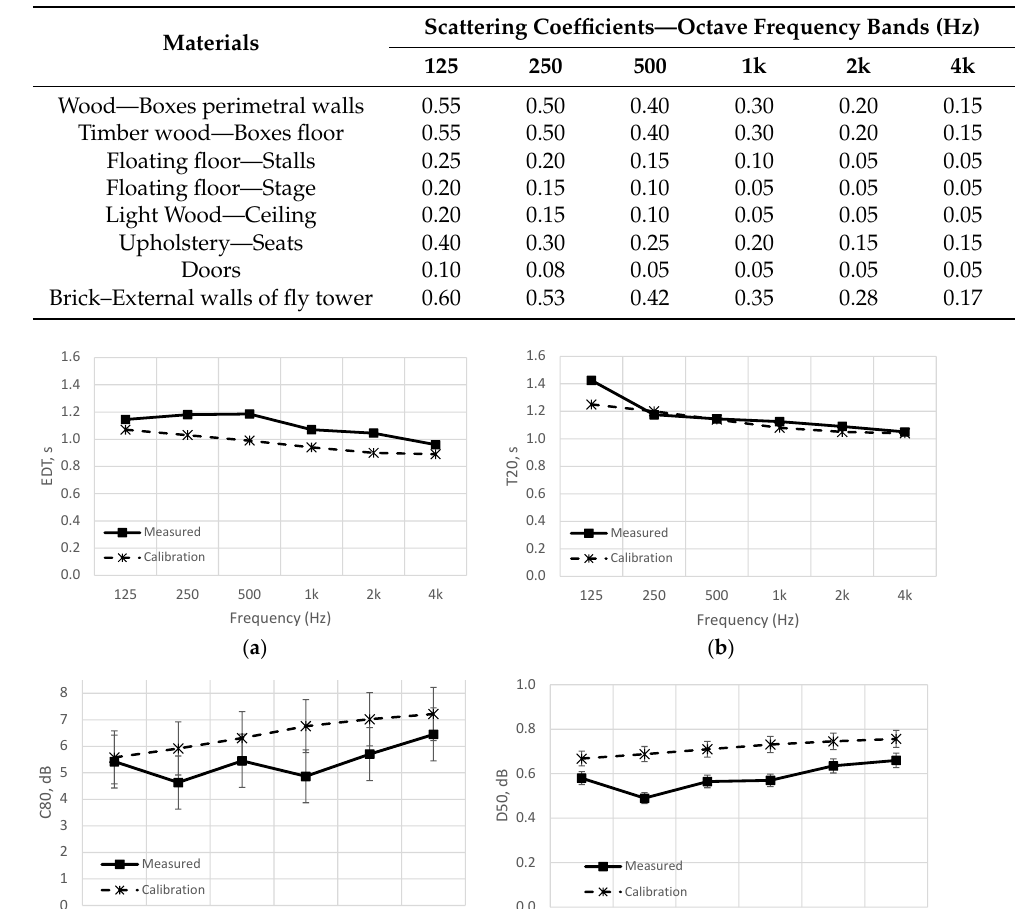
Table 5. Scattering coefficients of the materials considered in the model of Ponchielli theater of Cremona.